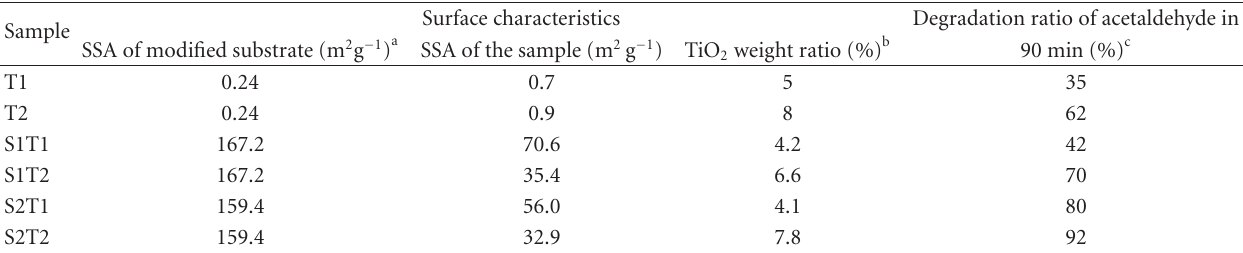
Table 1: Comparison of surface characteristics and photocatalytic behaviors of various TiO 2 and TiO 2 /SiO 2 films immobilized on foam nickel.